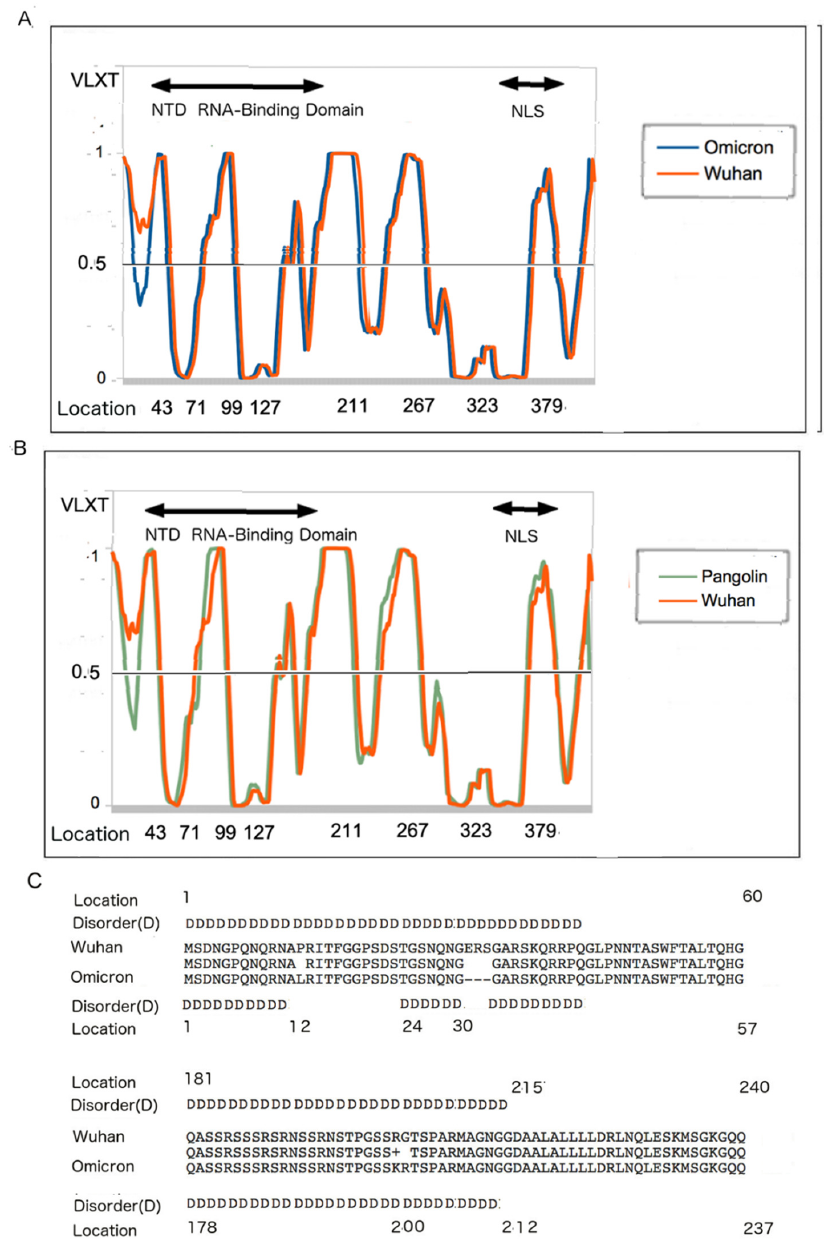
Figure 3. The PONDR ® VLXT plots and sequence peculiarities of different CoVs. Residues with the PONDR ® VLXT scores of 0.5 and above are considered disordered. ( A ) PONDR ® VLXT comparison of the N proteins the Wuhan-Hu-1 isolate and Omicron variant. ( B ) Comparison between the Wuhan-Hu-1 isolate and pangolin CoV 2017. ( C ) Sequence and disorder comparison of N proteins from the Wuhan-Hu-1 isolate and Omicron variant. Abbreviations: N-terminus RNA-Binding Domain (NTD RNA-Binding), Nuclear Localization Signal (NLS) [91].